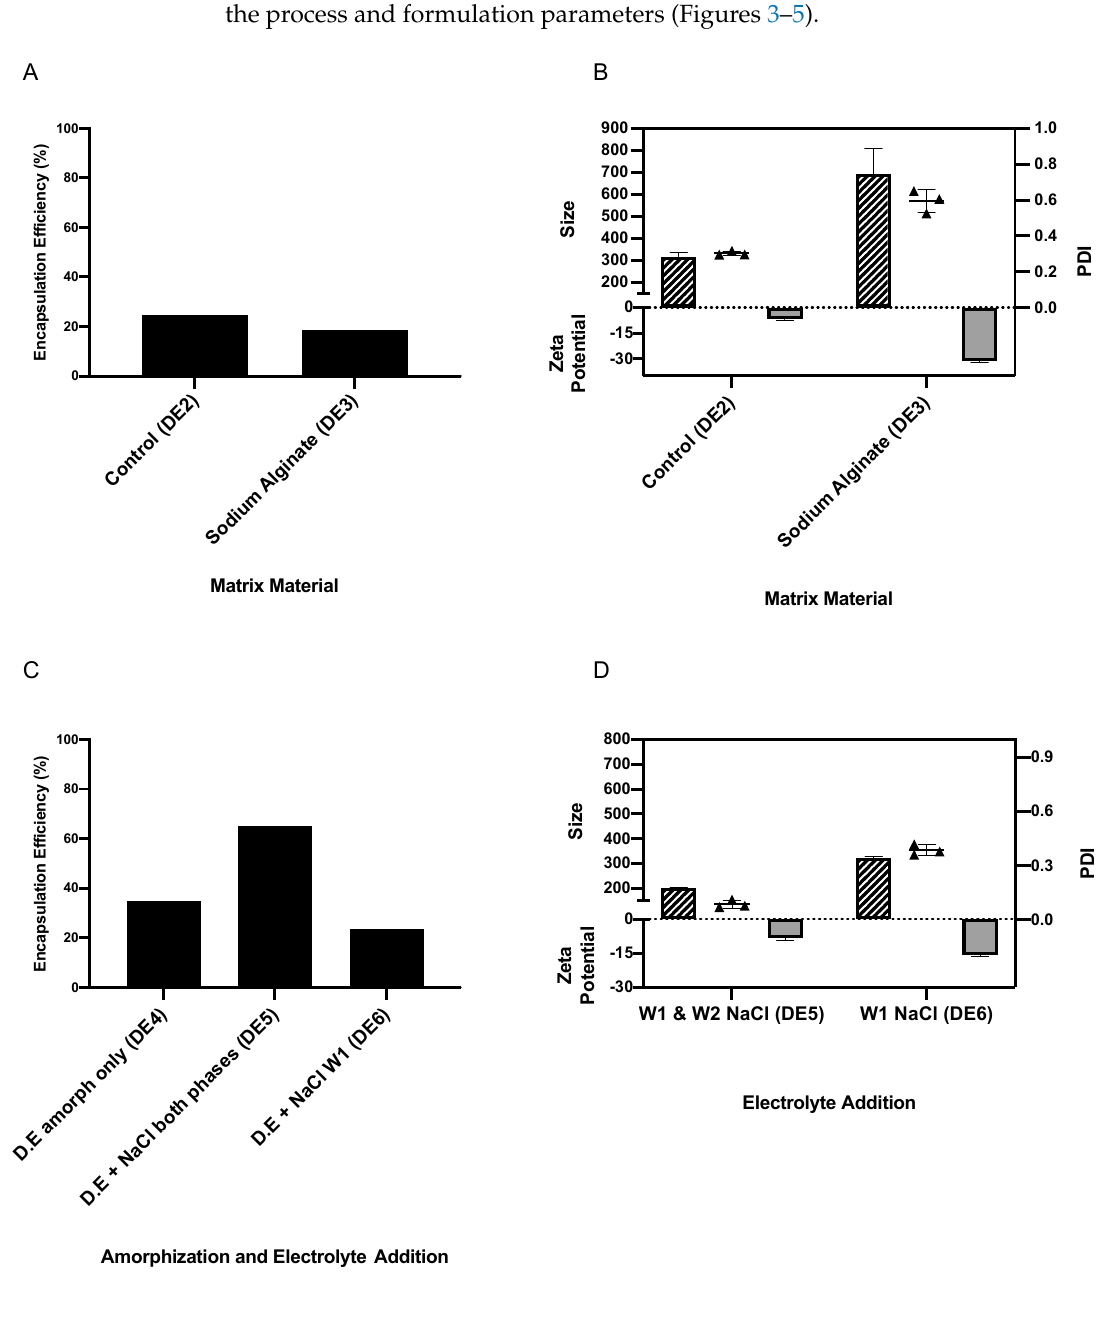
Figure 3. The impact of matrix material, PCL amorphization and electrolyte addition on the average particle size, PDI, zeta potential ( A , C ) and EE of nanoparticles ( B , D ) manufactured using the double emulsion technique.